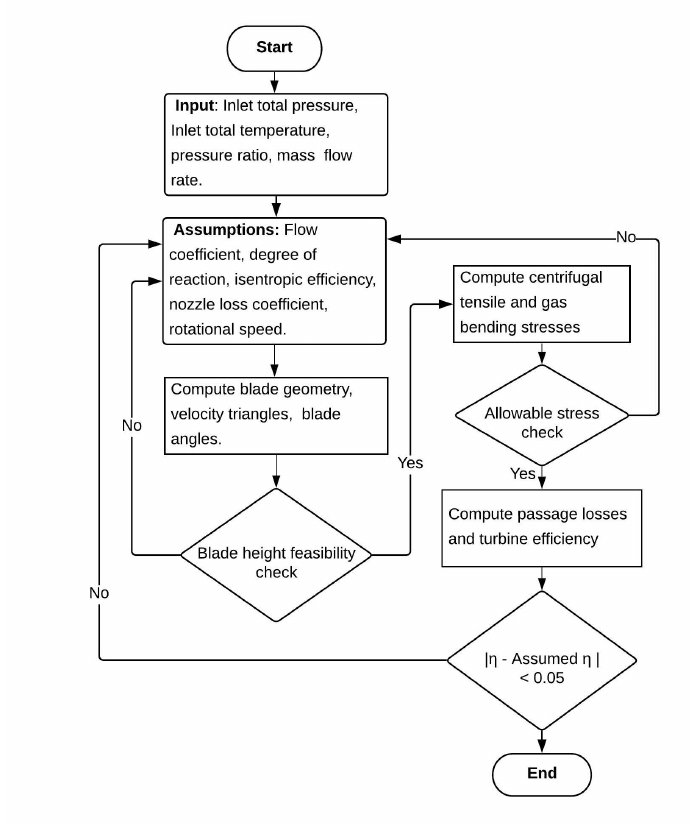
Figure 3. Design flow